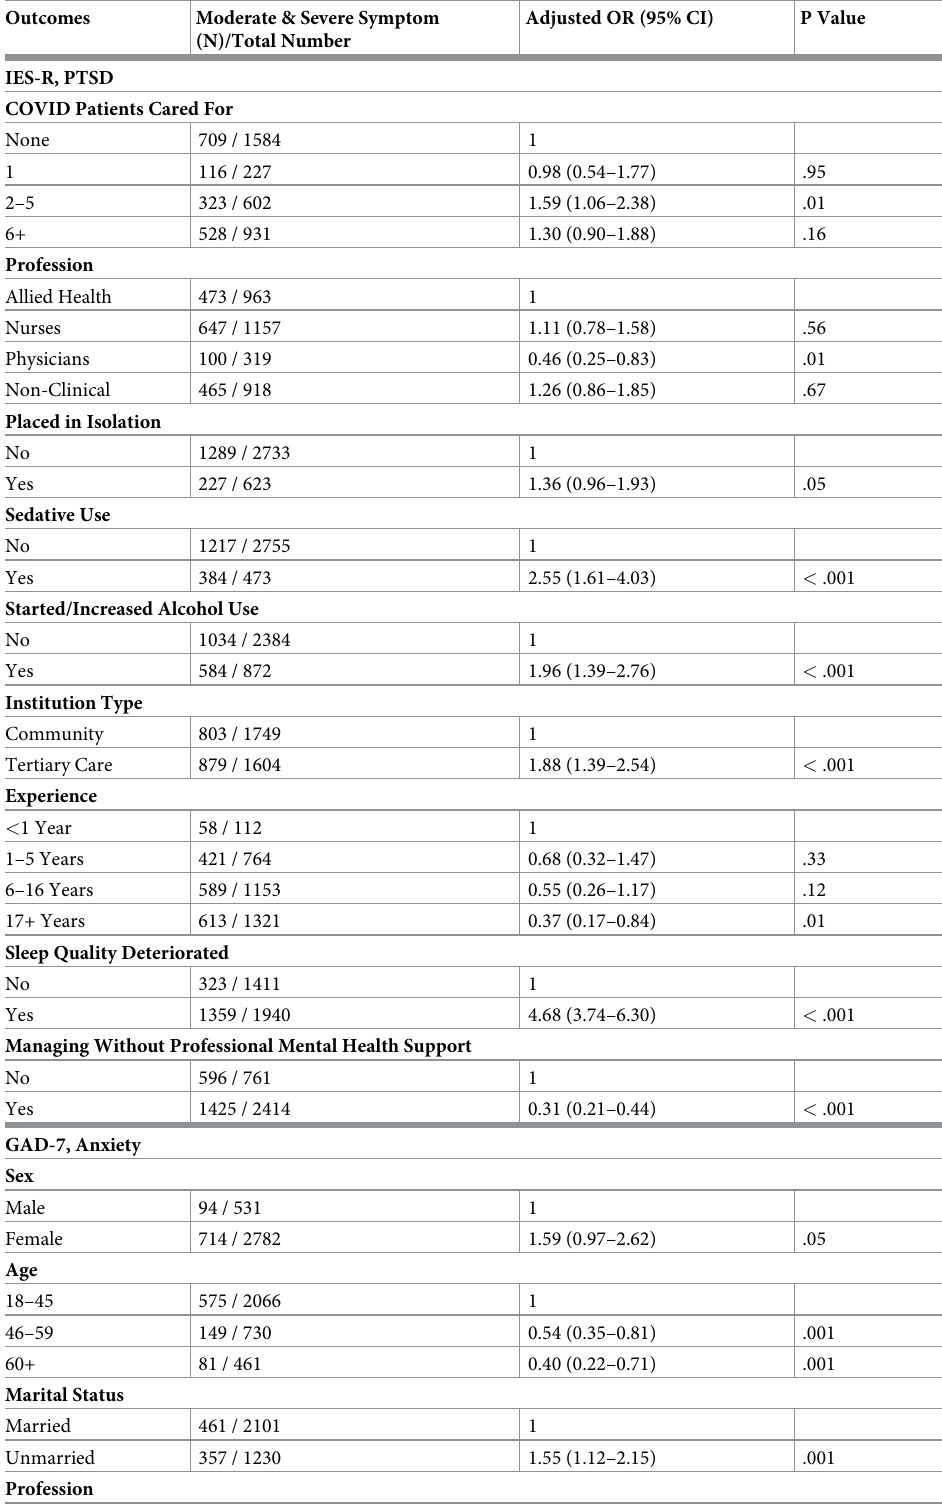
Table 5. Multivariable logistic regression analysis of identified risk factors for mental health